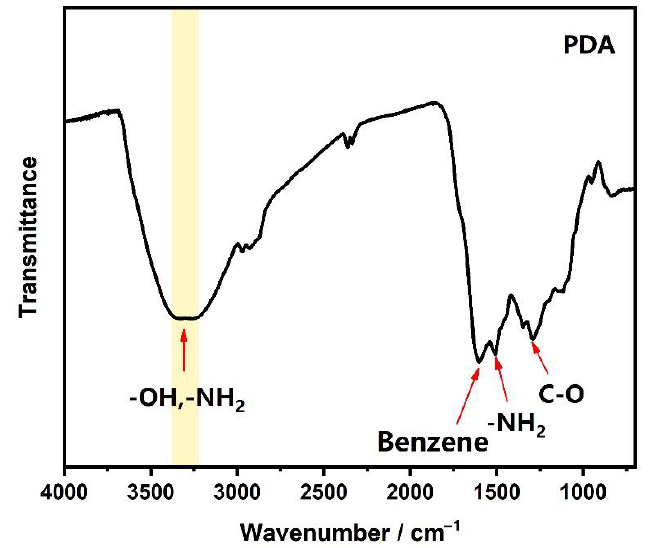
Figure 3. FT-IR spectra of PDA. The SEM images of PDA polymerized with different reaction times were shown in Figure 4. It can be found that when the polymerization time was about 0.5 h, the obtained material was mainly composed of particles of different sizes, which were nearly round in size and different in size. When the reaction time gradually increased, the existence of single particles gradually decreased, and the material particles began to stack gradually. When the reaction time reached 2 h, the surface of the sensitive film tended to be smooth, and the material accumulation was relatively flat. When the polymerization time reached 4 h, the surface of the film became no longer uniform, and a large number of particles accumulated on PDA due to agglomeration, which was detrimental to the uniform distribution of sensitive materials. Because the QCM sensor was worked in vibration mode, the non- uniform sensitive film would bring great negative impact to the sensor, and even lead to non-vibration of the QCM sensor